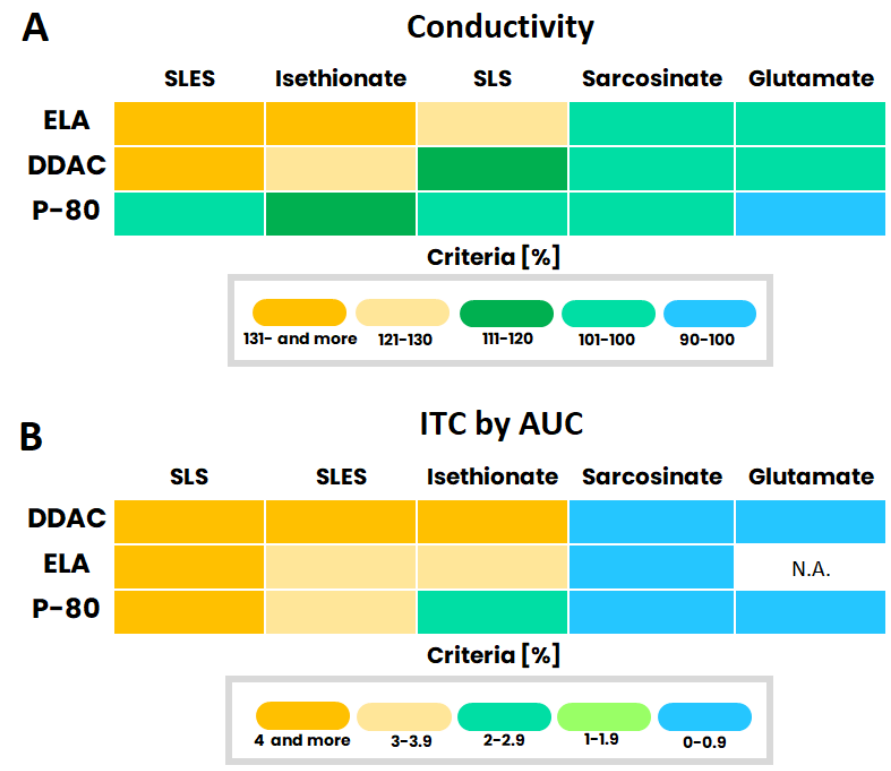
Figure 6. Heat maps summarizing the degree of ionic interactions between cationic and anionic species based on conductivity ( A ); and ITC ( B